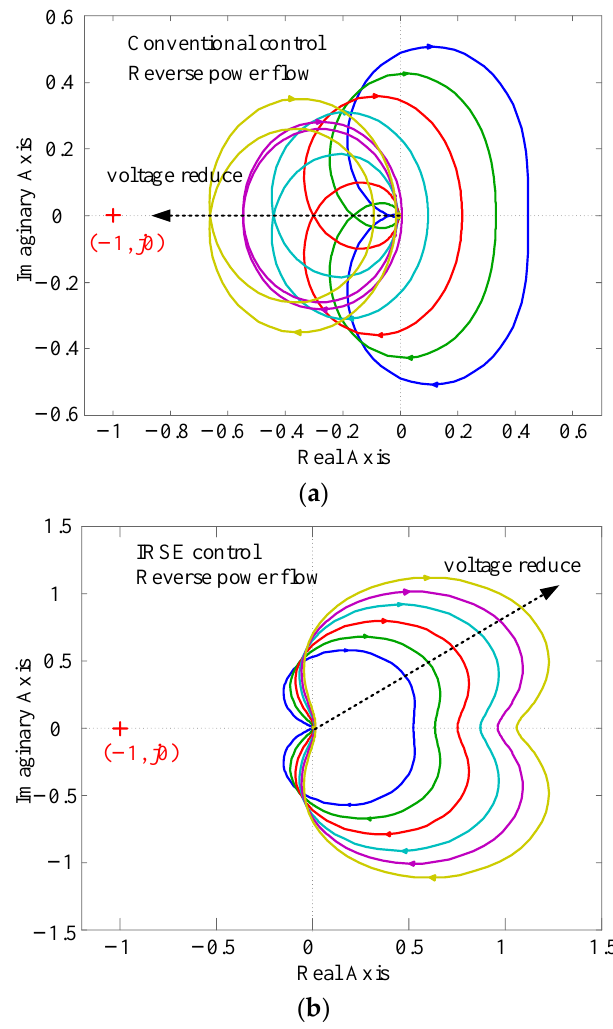
Figure 13. Nyquist plots obtained with voltage reduced for reverse power flow at 1.5 kW: ( a ) conventional control and ( b ) IRSE control.